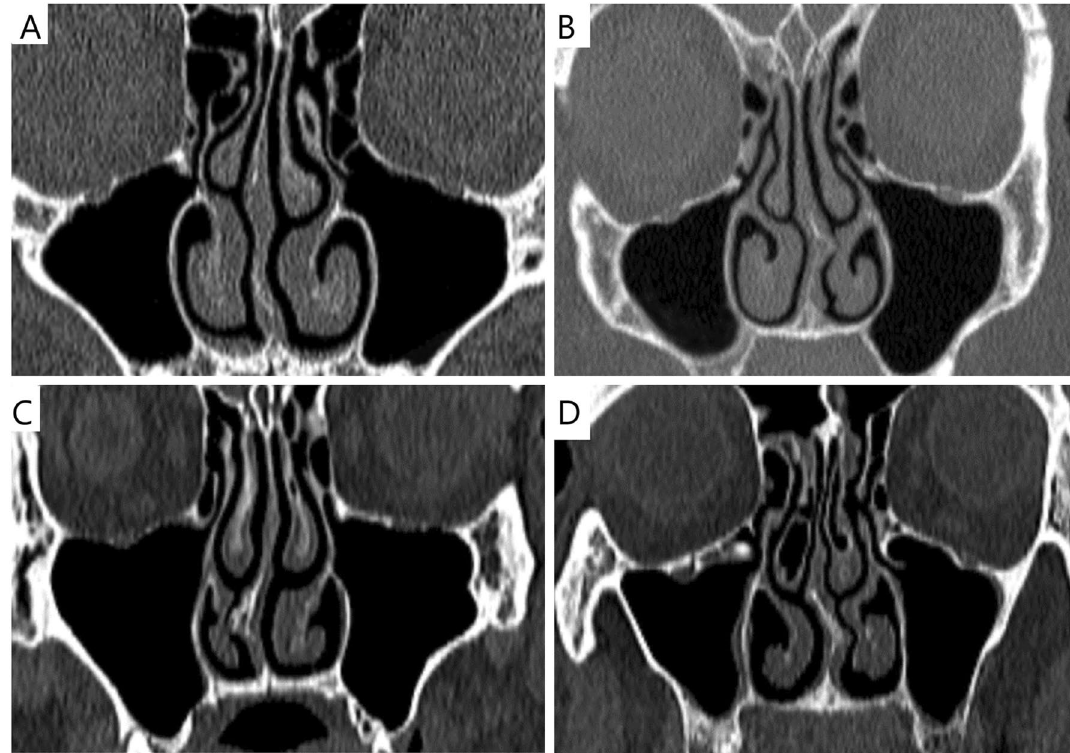
Figure 1. CT scans, frontal projection of the nasal sinuses. Maxillary sinus ostium level. ( A ) Patient 1 (norma); ( B ) Patient 2 (NSD in the left side and NTH); ( C ) Patient 3 (NSD in the right side); ( D ) Patient 4 (NSD in both side and